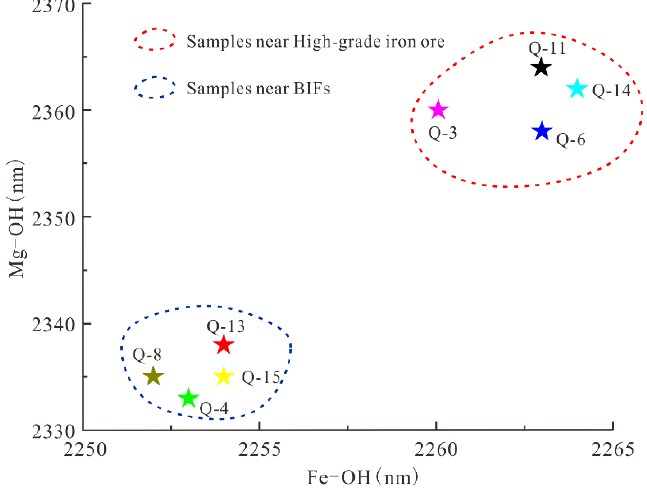
Figure 13. Scatter diagram of the wavelength positions near 2250 and 2350 nm extracted from the point spectra.